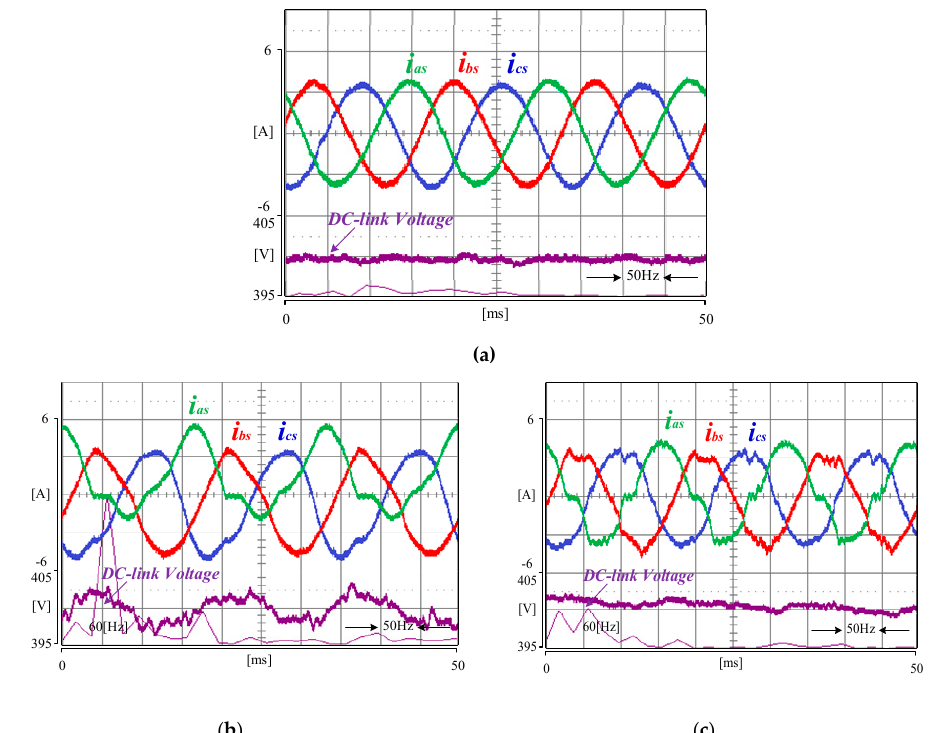
Figure 13. Experimental result for open-switch fault diagnosis algorithm.